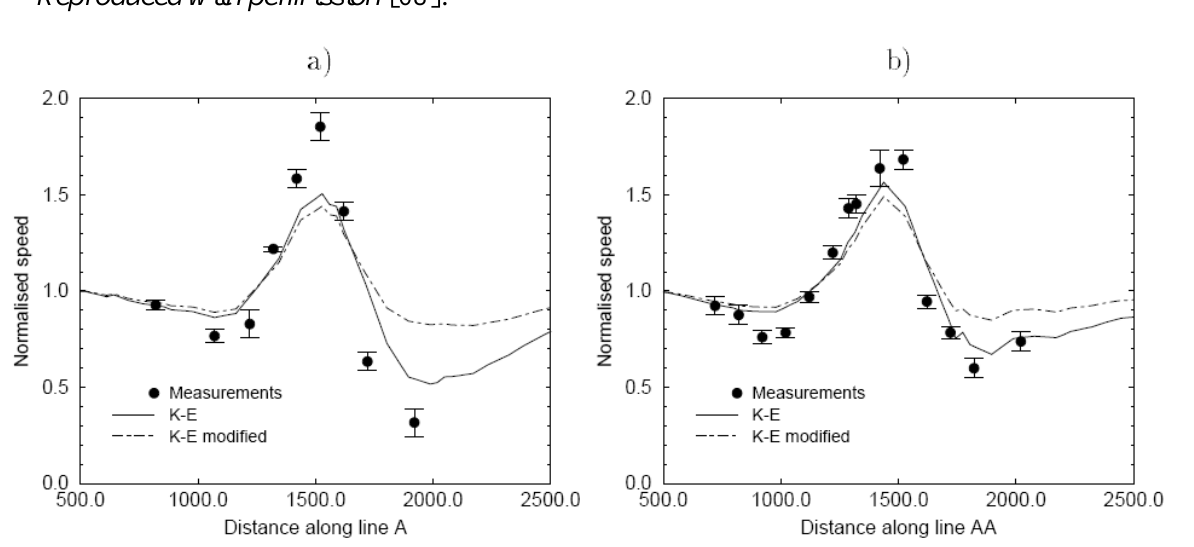
Figure 21. Normalized wind speed over the Askervein Hill for section A (a) and AA (b). Reproduced with permission